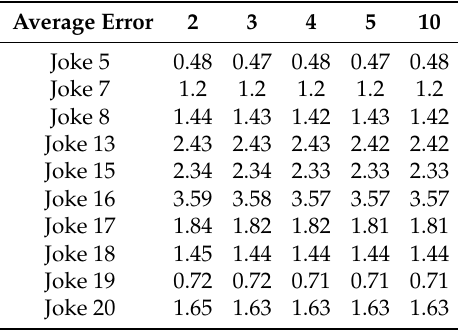
Table 21. Average rounding error for Jester